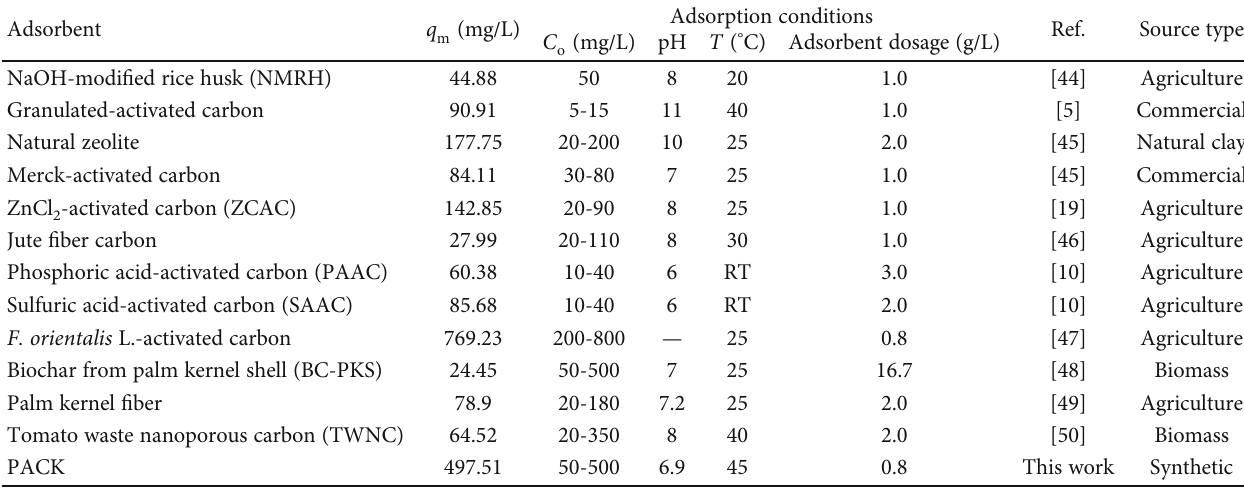
Table 5: Comparison of the CV adsorption capacities of various reported